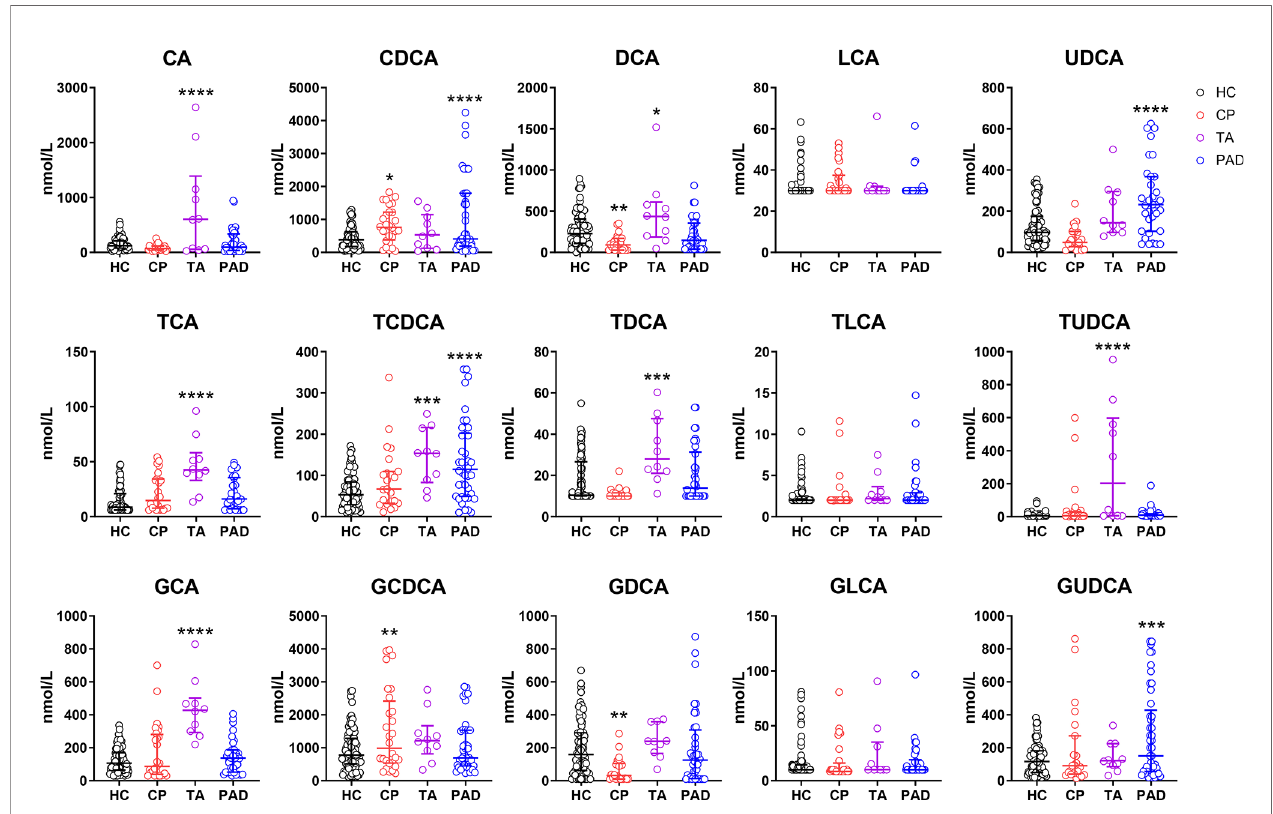
FIGURE 1 | Bile Acids are Altered in Chronic Periaortitis Patients. Serum was collected from healthy controls (n=88, shown in black) as well as the patients of chronic periaortitis (CP) (n=28, shown in red), Takayasu ’ s arteritis (TA) (n=10, shown in purple) and peripheral artery disease (PAD) (n=47, shown in blue) and tested by ultra performance liquid chromatography-tandem mass spectrometry (UPLC-MS/MS). Bile acid spectrum in diverse groups were then analyzed. Data are shown as median (IQR). * means patients ’ data comparing to healthy controls, respectively. *p < 0.05; **p < 0.01; ***p < 0.001; ****p < 0.0001, one-way ANOVA, followed by Dunnett ’ s multiple comparisons test. CA, cholic acid; TCA, taurocholic acid; GCA, glycocholic acid; CDCA, chenodeoxycholic acid; TCDCA, taurochenodeoxycholic acid; GCDCA, glycochenodeoxycholic acid; DCA, deoxycholic acid; TDCA, taurodeoxycholic acid; GDCA, glycodeoxycholic acid; LCA, lithocholic acid; TLCA, taurolithocholic acid; GLCA, glycolithocholic acid; UDCA, ursodeoxycholic acid; TUDCA, tauroursodeoxycholic acid; GUDCA, glycoursodeoxycholic